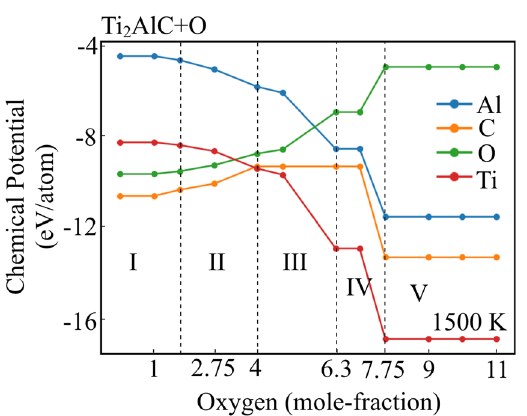
Fig. 6 Chemical activity of elements during oxidation process. Oxidation reaction chain showing change in chemical potential of Ti 2 AlC as a function of changing molar percent oxygen at 1500 K. On oxidation, the partial chemical potentials of Ti/Al/C reduce while the chemical potential of invading O 2 increases (see Supplementary Fig.